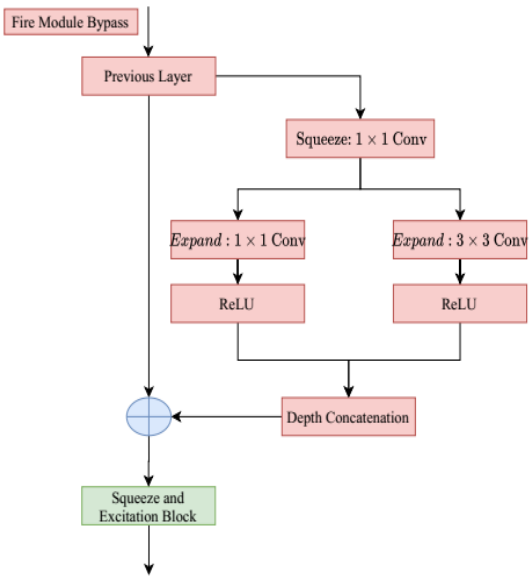
Figure 10. Fire-module Bypass,